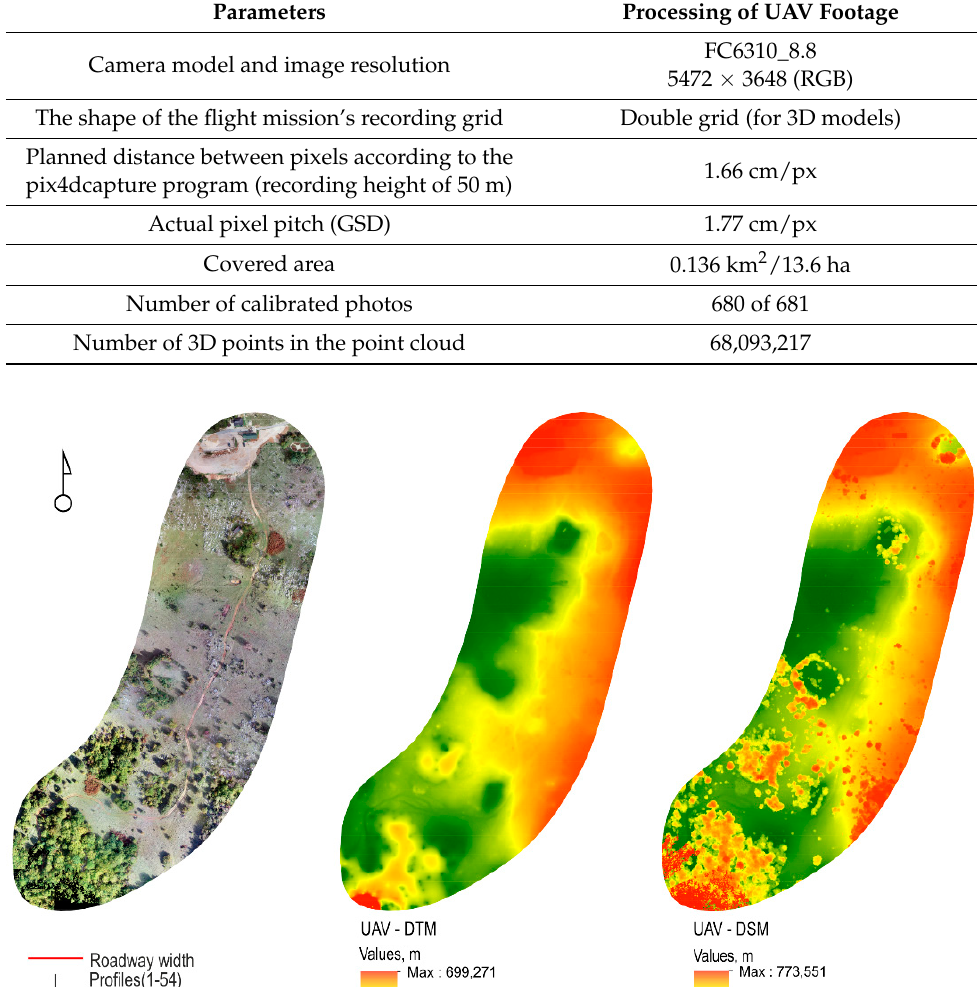
Table 1. Parameters of the processed footage of the UAV device.